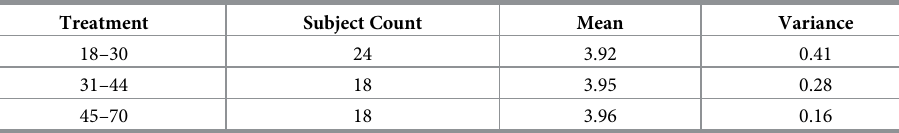
Table 29. Data summary—Viewpoint #11.